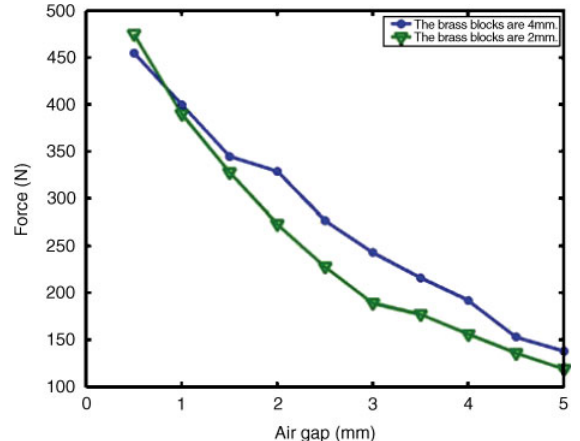
Figure 11 Influence of thickness of the brass blocks.